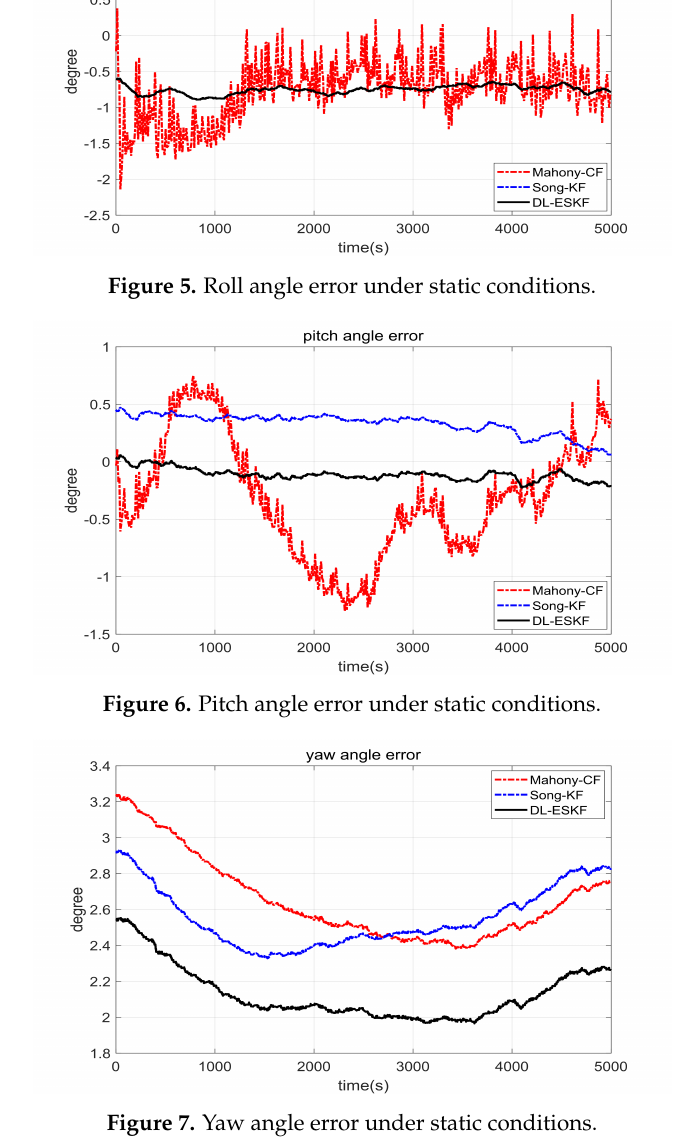
Figure 7. Yaw angle error under static